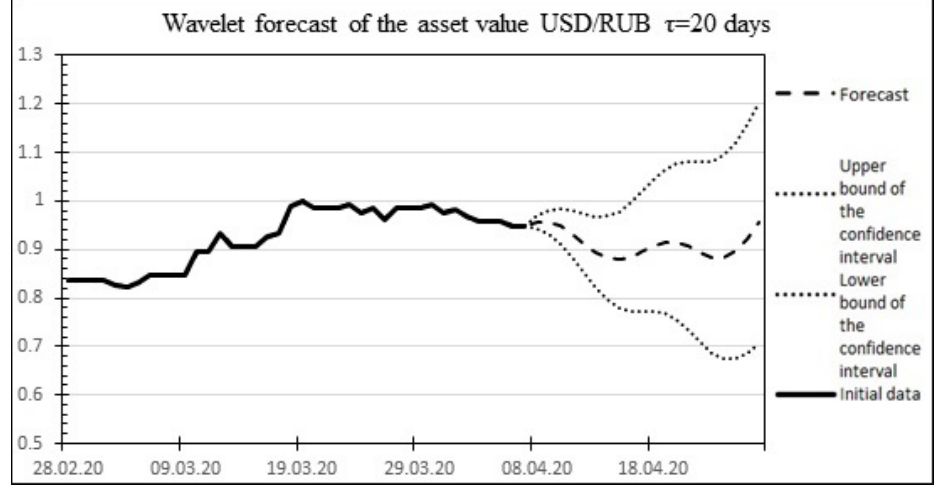
Figure 5. The result of the wavelet forecast for 20 days ahead for the USD/RUB asset.